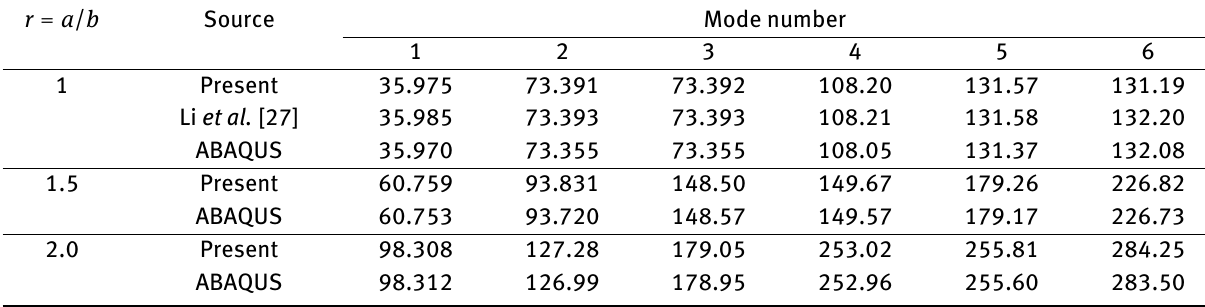
Table 4: Comparison of the first six frequency parameters Ω for the rectangular thin plate with C-C-C-C boundary condition. r = a / b